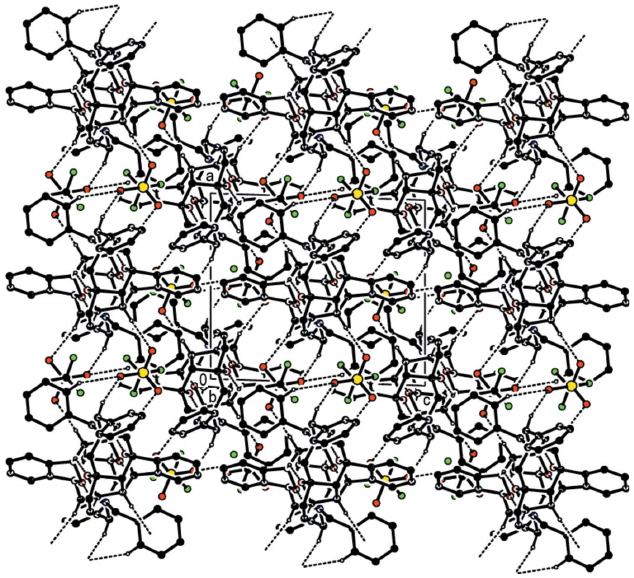
Figure 5 Packing of the title salt 1 viewed along the b- axis direction with C—